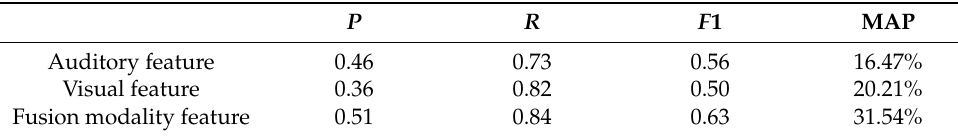
Table 5. Fusion modality feature recognition results.